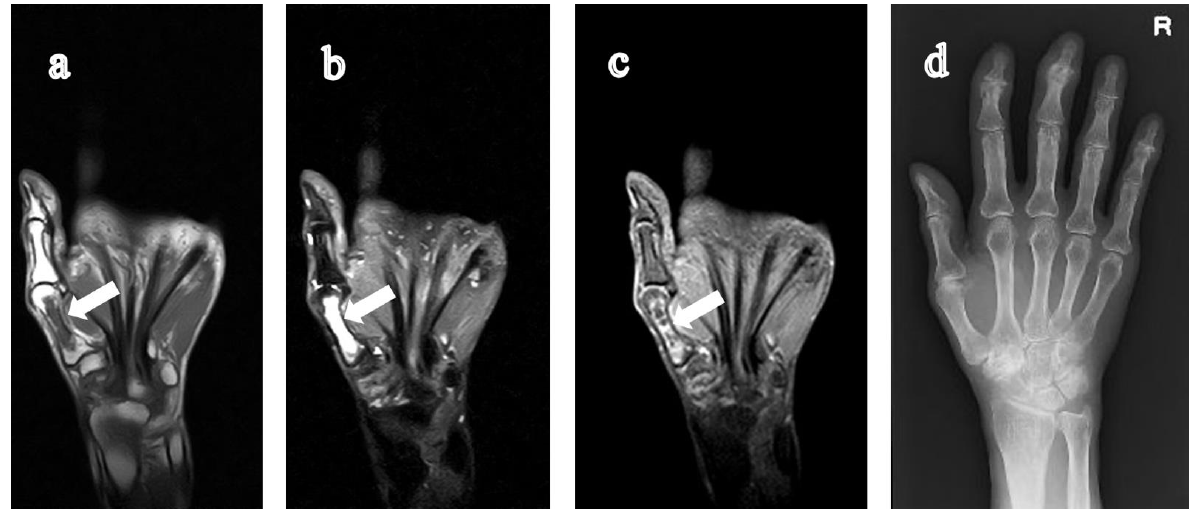
Figure 3. 84-year-old woman with rheumatoid arthritis for six years. On T1-weighted coronal image ( a ) and STIR coronal image ( b ), a giant lesion is detected, which originated from the proximal aspect of the 1st metacarpal bone of the right hand and extended to the central diaphysis. ( c ) The internal enhancement of the cystic lesion can be seen on the contrast-enhanced fat-suppressed T1-weighted coronal image. ( d ) The lesion cannot be detected on CR. RA, rheumatoid arthritis; STIR, short tau inversion recovery; CR, computed radiography.